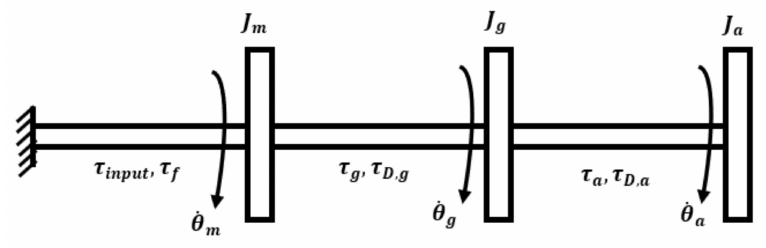
Figure 3. Nonlinear robotic arm dynamics model.